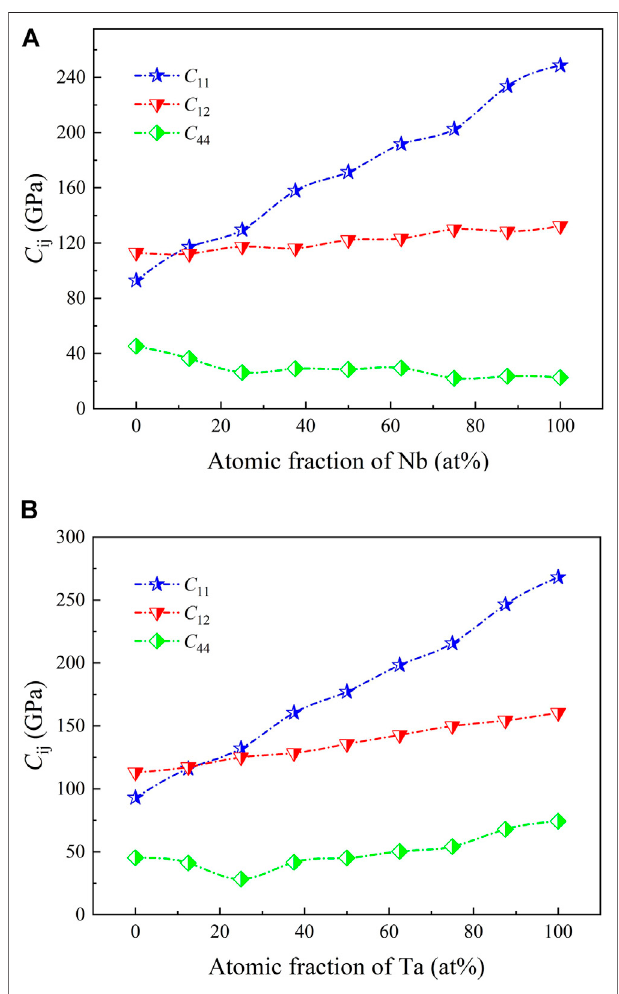
FIGURE 5 | Single-crystal constants of (A) β -TiNb and (B) β -TiTa alloys.